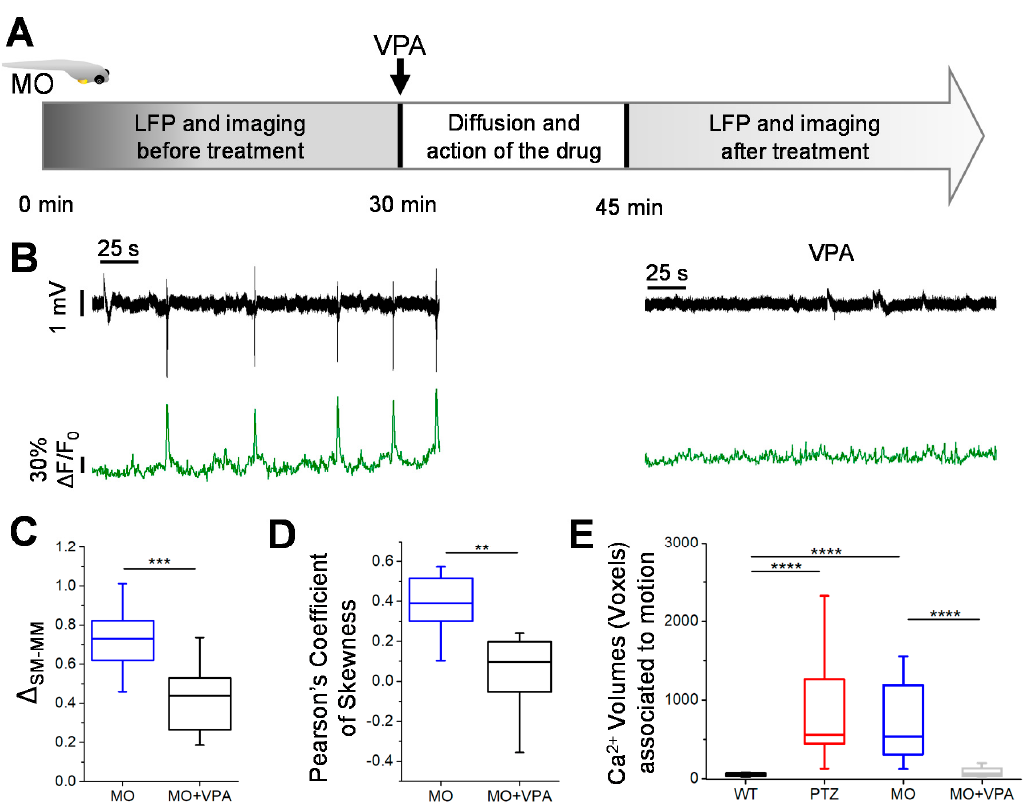
Figure 3. Valproate treatment. ( A ) Valproate (2 mM) was administered to MO kcnj10a larvae after 30 min of baseline recording of LFP and two-photon imaging. After a diffusion time of 15 min, the double recording was resumed. ( B ) Alignment of LFP and Δ F/F0 calcium traces in MO VPA( Valproic Acid)-treated larvae. ( C ) The analysis of the statistical distribution of the electrophysiological signal showed a clear effect of VPA in decreasing the energy of the LFP events. ( D ) The skewness of statistical distributions of Ca 2+ fluctuations decreased during VPA treatment. ( E ) During VPA treatment, movements of the larvae did not correlate with a generalized increase of calcium signal. Therefore, VPA treatment led to a physiological phenotype, where tail flicks are associated not to a convulsive seizure but to the activation of a limited neuronal circuitry. 2 recordings for each larva, n = 3 larvae for each condition (* p ≤ 0.05, ** p ≤ 0.01, *** p ≤ 0.001, **** p ≤ 0.0001).